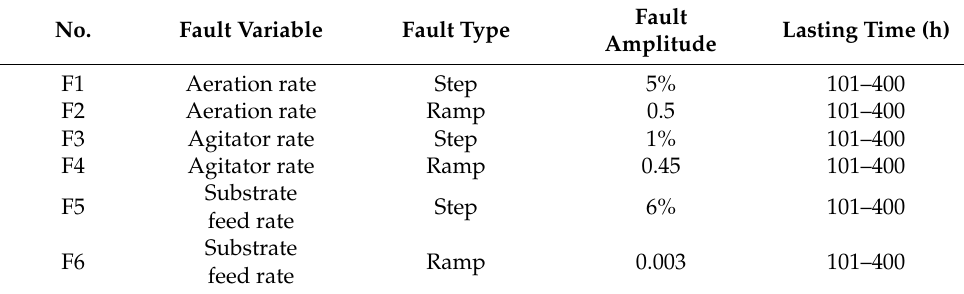
Table 1. Six fault patterns in the penicillin fermentation